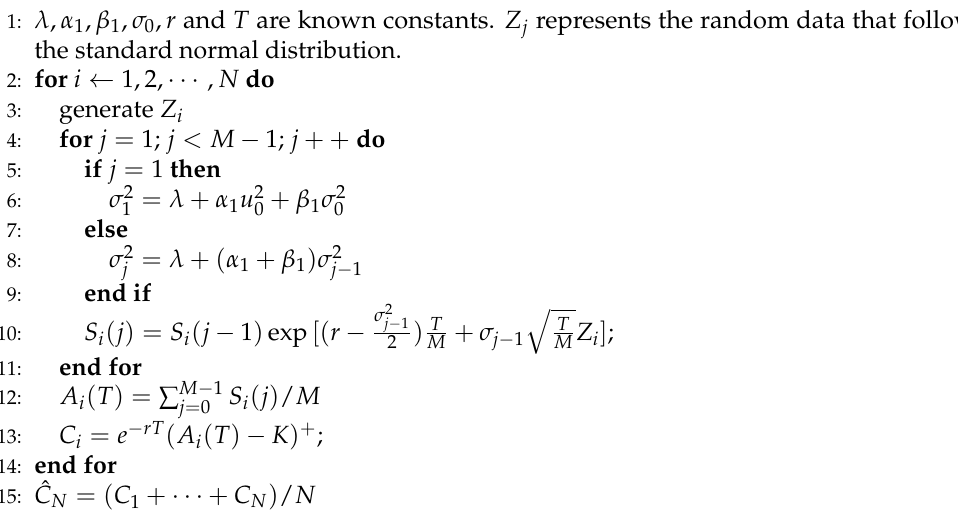
Algorithm 1 MC algorithm to estimate expected present value of